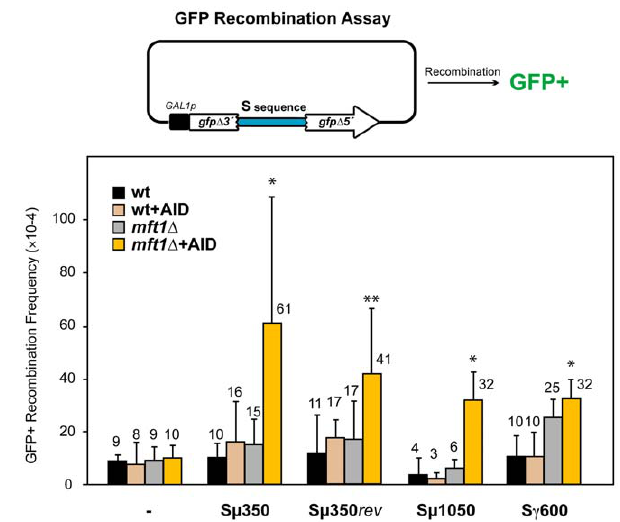
Figure 1. AID–induced recombinogenic effect of different murine S sequences in wild-type and THO mutants. A diagram of the direct-repeat recombination system is shown on top. GFP-based direct-repeat recombination was detected by FACS in wild-type and mft1 D strains, with or without AID overexpression. Recombination frequencies were obtained as the median value of at least six independent colonies, and are indicated on top of each bar. Median values and the corresponding standard deviations are shown. Statistical analyses were performed with a Mann-Whitney test compared with the control carrying no S sequence cells. * p , 0.001, ** p ,